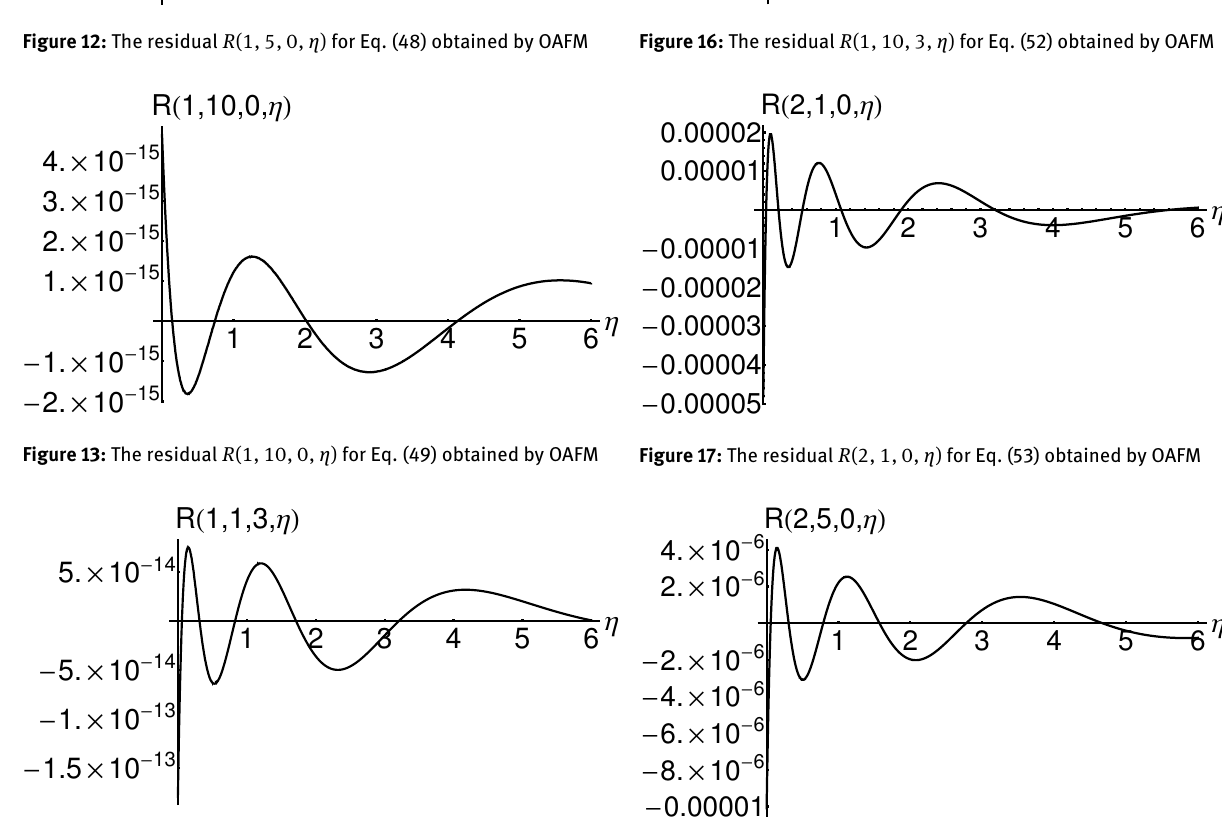
Figure 18: The residual R (2, 5, 0, η ) for Eq. (54) obtained by